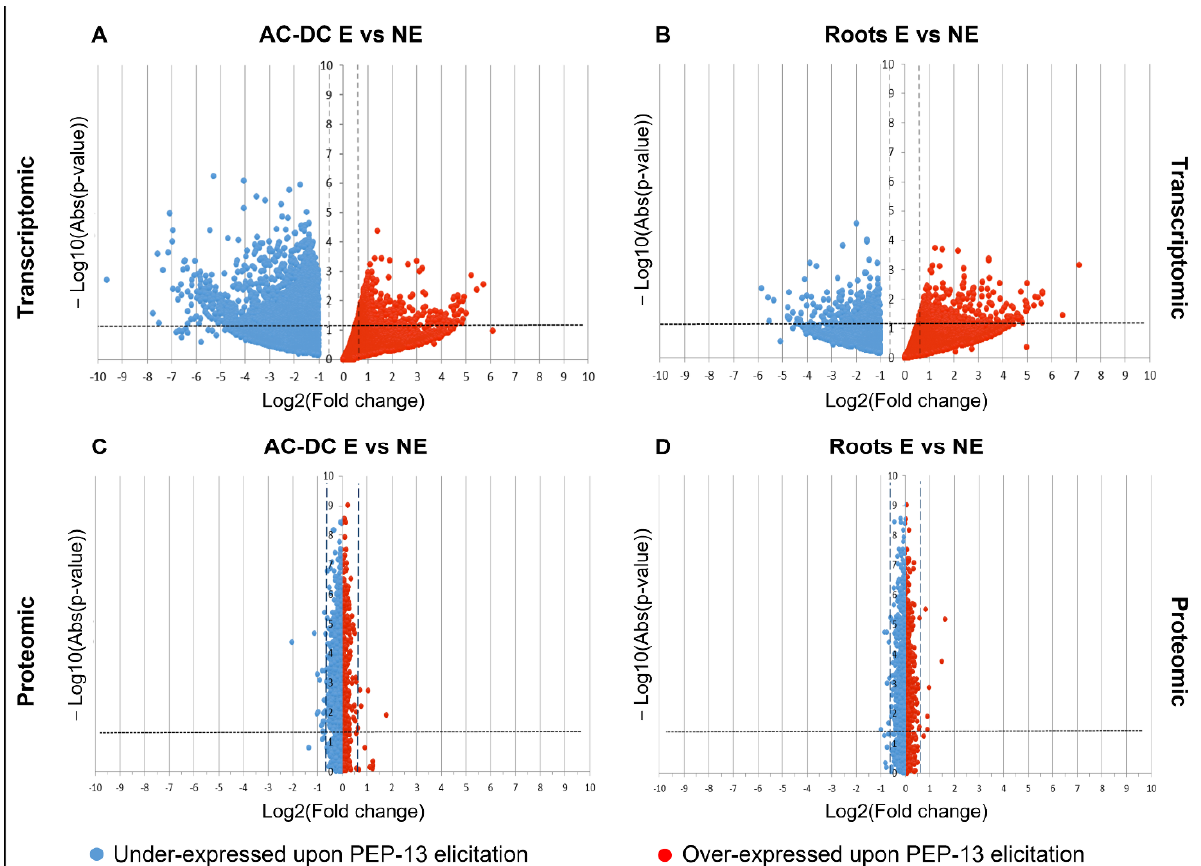
Figure 3. Differential expression analysis of genes ( A , B ) and proteins ( C , D ) upon PEP-13 elicitation in roots ( B , D ) and root AC-DC ( A , C ). These volcano plots were obtained from transcriptomic ( A , B ) and proteomic ( C , D ) data. Blue points correspond to genes and proteins that are under-expressed upon PEP-13 elicitation. Red points correspond to genes and proteins that are over-expressed upon PEP-13 elicitation. The number of under- and over-expressed genes and proteins for each method appears in blue (under-expressed) and red (over-expressed) squares. DEG = differentially expressed genes; DEP = differentially expressed proteins (fold change ≤ 0.66 or fold change ≥ 1.5; p -value ≤